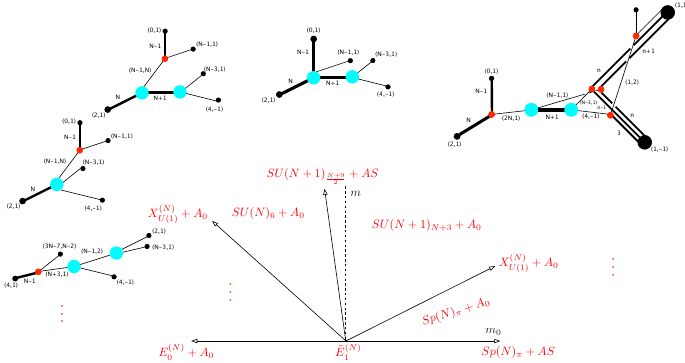
Figure 16 . The first few phases of ˜ E N